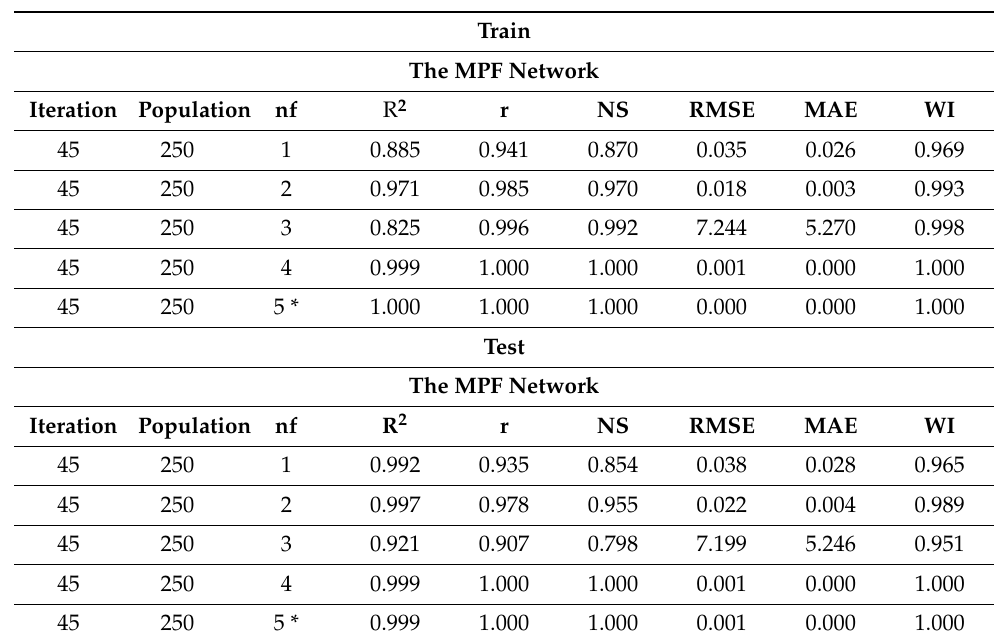
Table 10. Calculated accuracy criteria for the performance of the implemented models to displace- ment prediction (iteration =